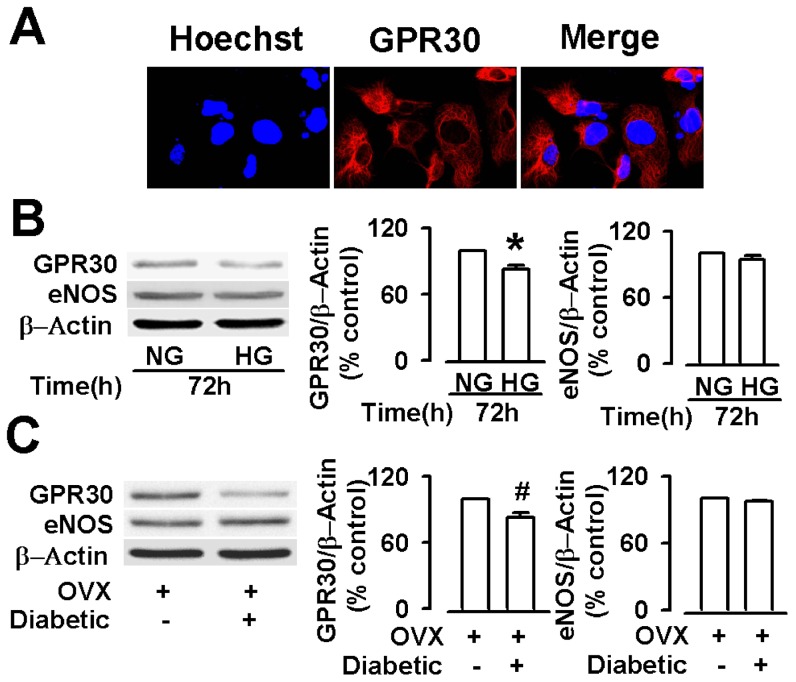
The expressions of GPR30 and eNOS protein in endothelial cells and aortas.(A) GPR30 expression in endothelial cells from intact SD female rats (red = GPR30). (B) Western Blot analysis of GPR30 and eNOS expression showed that cultures of the endothelial cells maintained in high glucose (HG, 33 mM) showed reduction in GPR30 expression compared to normal glucose (NG, 5 mM). (C) Western Blot analysis of GPR30 and eNOS expression also showed reduction in GPR30 expression in the aortas from diabetic OVX rats compared to those from diabetic OVX rats. *
p<0.05 compared with NG; #
p<0.05 compared with OVX rats. Results are given as the mean ± SEM of three independent experiments.